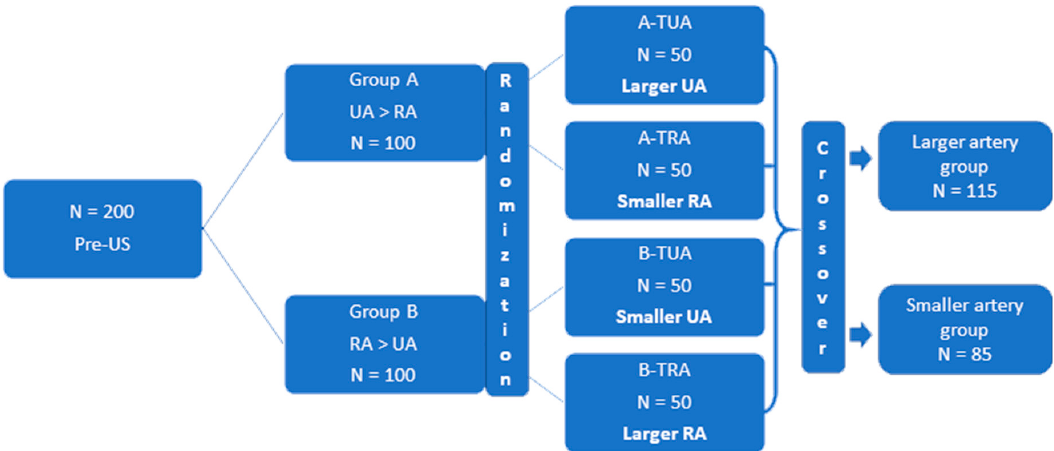
Figure 2. Allocation of patients after layered randomization into larger and smaller artery group. Pre-